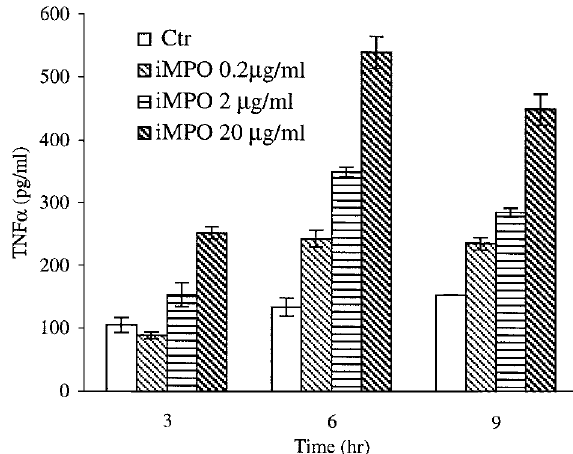
FIG. 1. Induction of tumor necrosis factor-alpha (TNF a ) by enzymatically inactive myeloperoxidase (iMPO). Resident rat peritoneal macrophage (Mø) were cultured in a 96 well Costar plate. After a 2-hour incubation, the cells were washed, and either treatments or media alone were added. The supernatants from treated and control wells were collected and stored at –70°C until used for an ELISA. Manufacturer’s instructions were